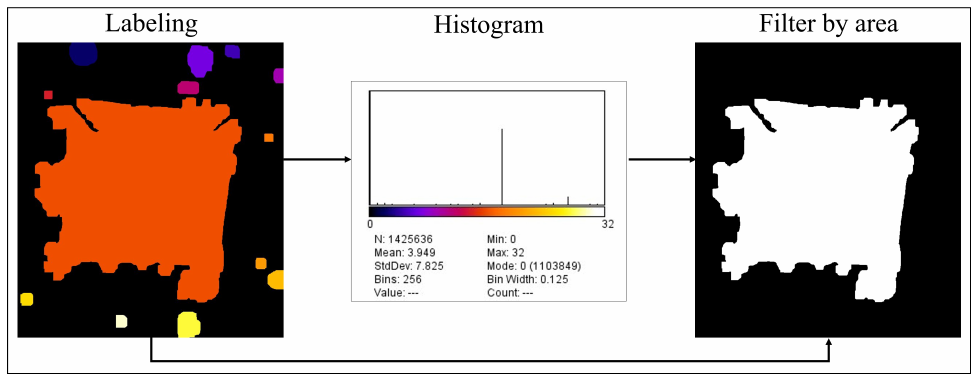
Figure 8. Label and area